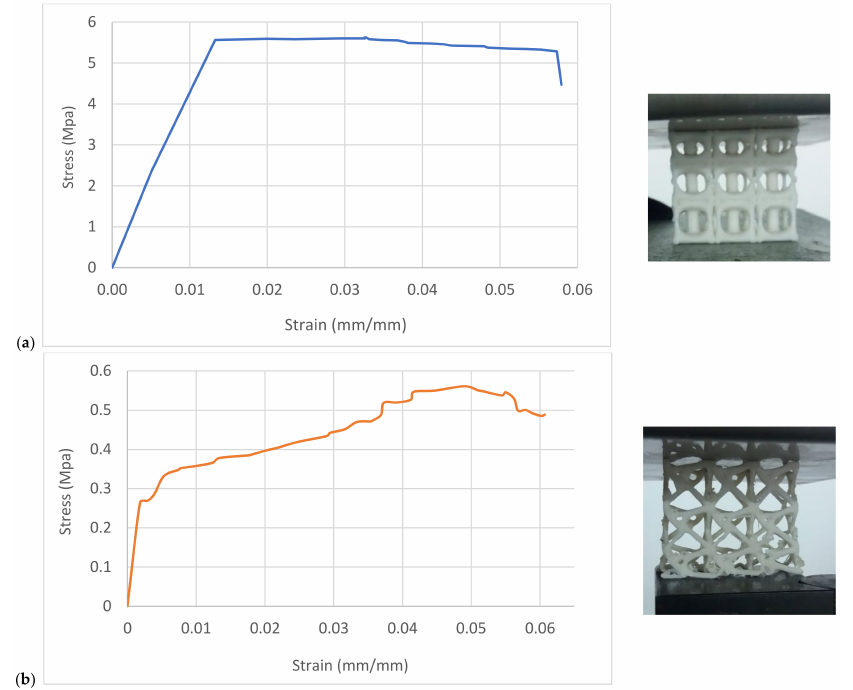
Figure 18. Specimens’ behavior during the compression test: ( a ) lattice structure #1 and ( b ) lattice structure #2.